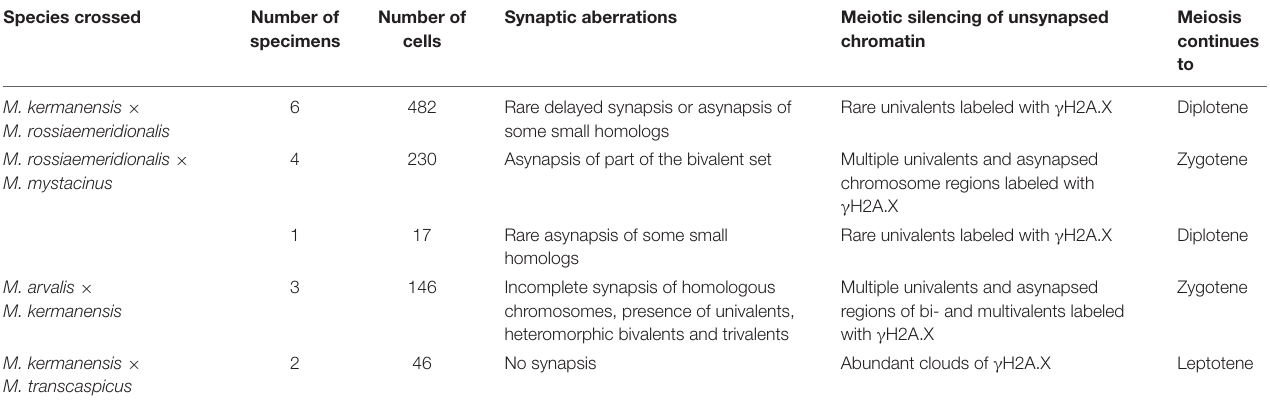
TABLE 4 | Meiotic aberrations detected in the interspecies hybrid male gray voles. Species